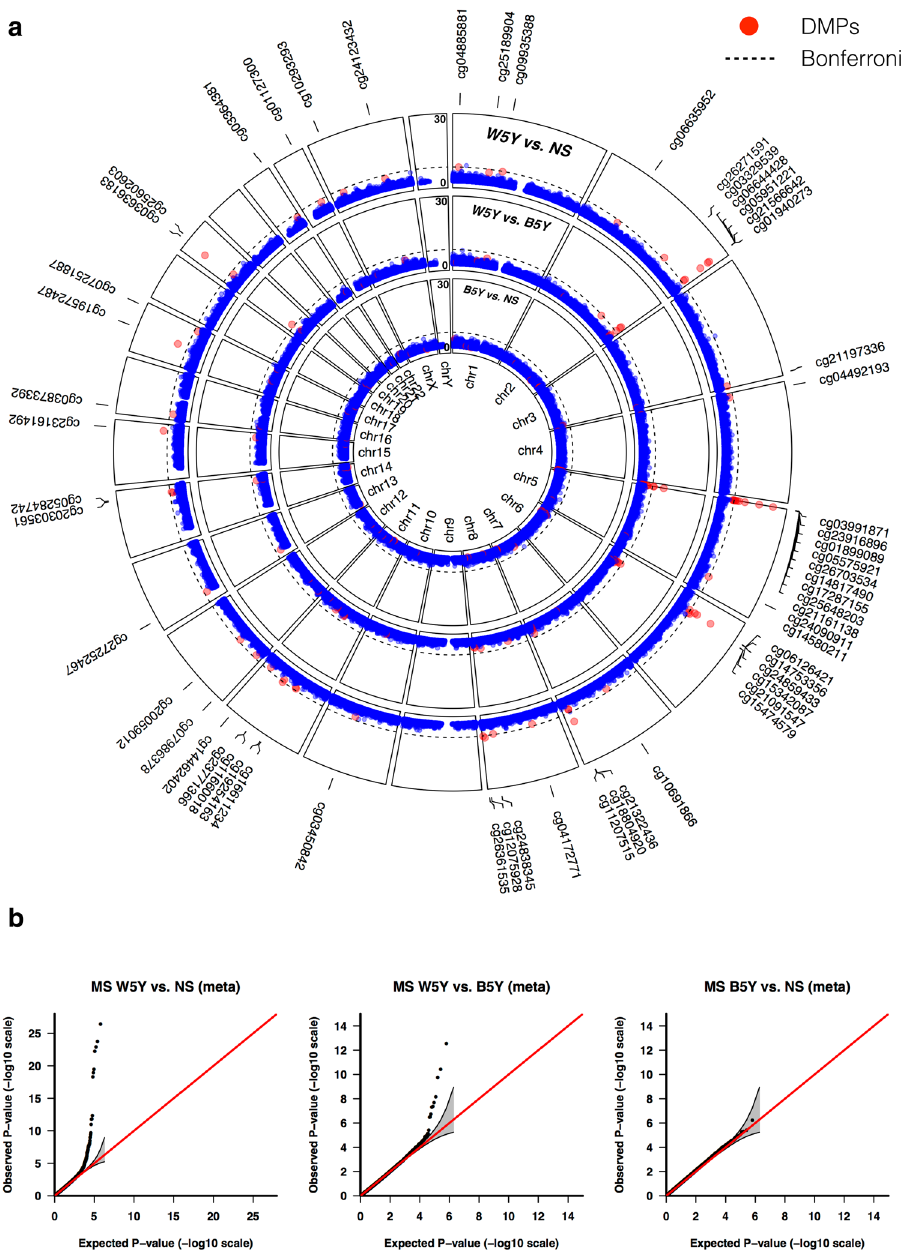
Figure 1. Smoking induces DNA methylation changes that are attenuated five years after smoking cessation. ( a ) A circular Manhattan plot is shown for the − log 10 P-values obtained from the meta-analysis of the S and B cohorts, for the comparisons W5Y vs . NS, W5Y vs . B5Y and B5Y vs . NS (outmost to innermost circle). A dashed line indicates the genome-wide significant level (Bonferroni, 1.14 × 10 − 07 ) and a red dot marks the 58 DMPs selected as indicated in the main text. ( b ) P-P plot of the expected vs . observed − log 10 P-values for the comparisons W5Y vs . NS, W5Y vs . B5Y and B5Y vs . NS respectively. The 0.95 confidence interval is indicated by a grey shaded area and is calculated under the assumption of the P-values being drawn independently from a uniform [0, 1]